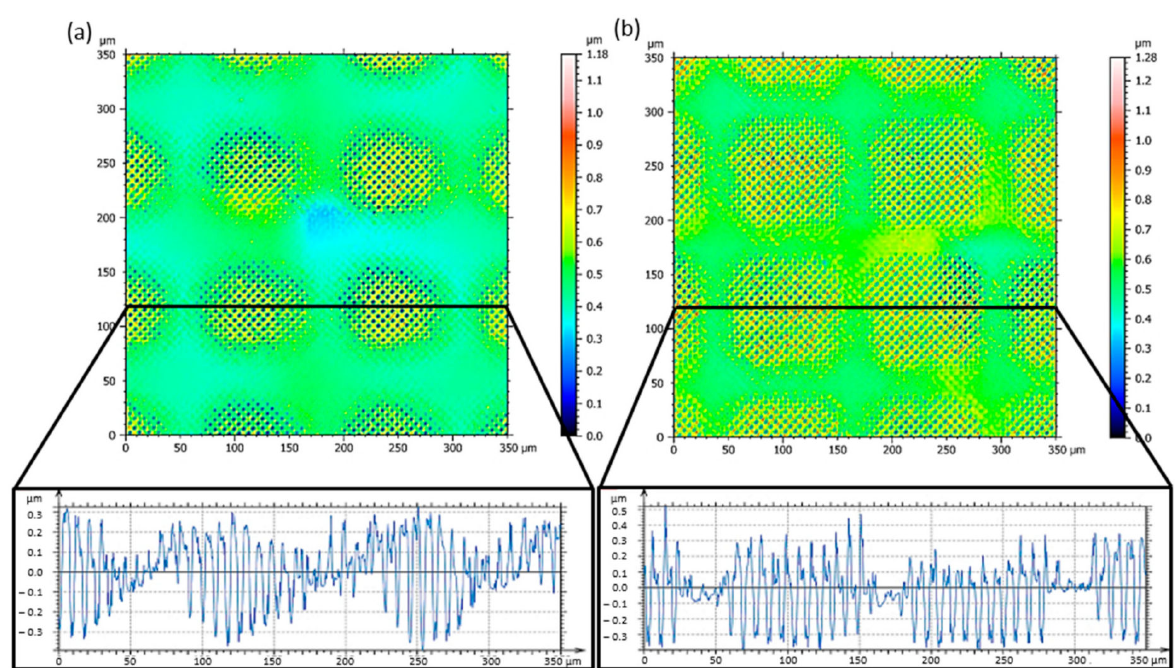
Figure 3. Confocal microscope images of surface topographies produced in stainless steel and corresponding surface profiles using the ( a ) Gaussian and ( b ) top-hat beam profiles. Only one laser pulse was used for each spot. The laser fluence was 2.97 J/cm 2 and the hatch distance was 130 µ